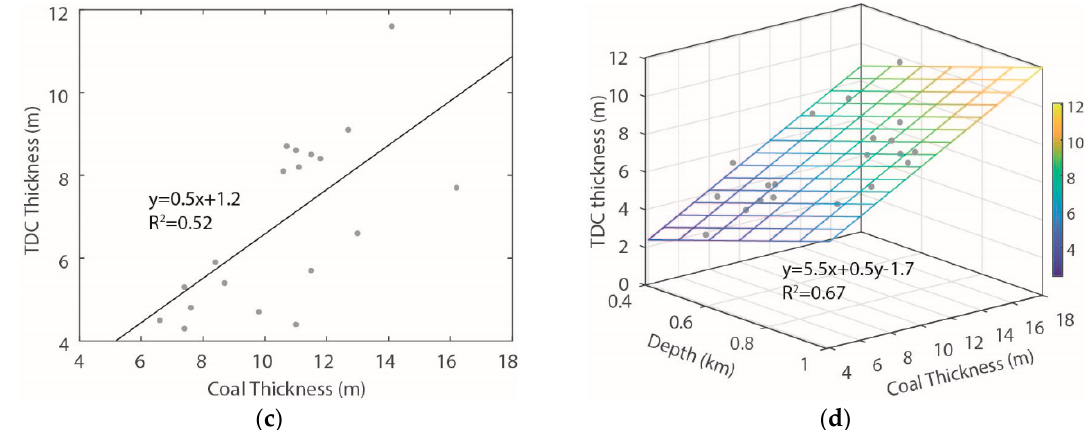
Figure 11. Cross plots of coal thickness vs. depth ( a ), TDC thickness vs. depth ( b ), TDC thickness vs. coal thickness ( c ), and TDC thickness vs. depth and coal thickness ( d ).